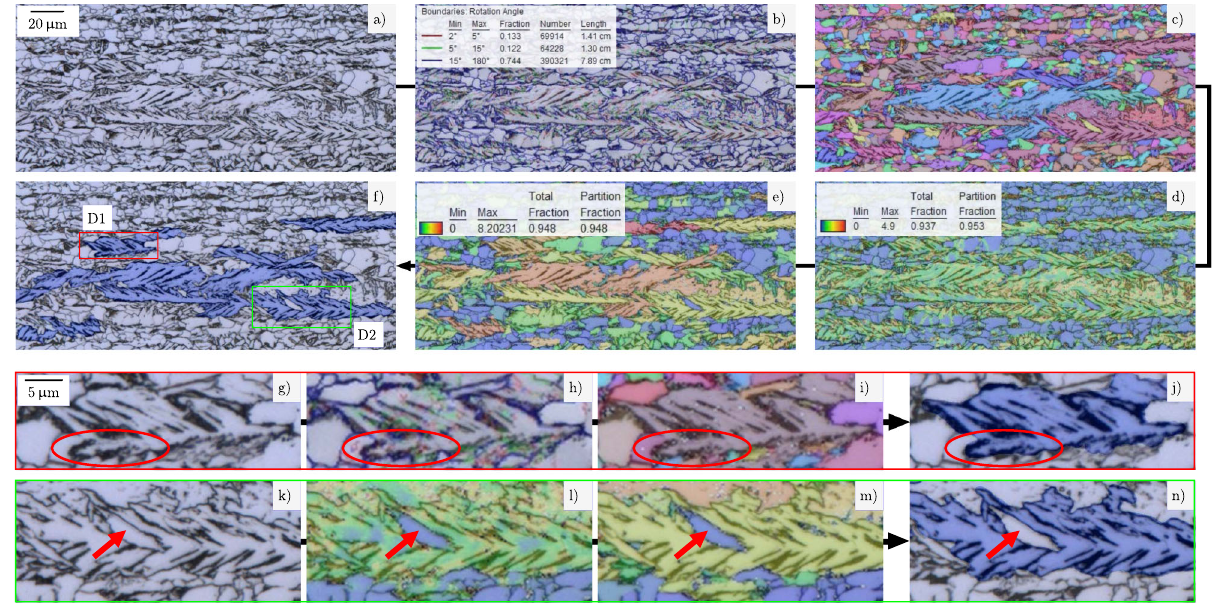
Fig. 1 Illustration of correlative microscopy approach for objectively annotating lath-bainite regions. a Original LOM micrograph. LOM overlayed with b an EBSD-derived grain boundary map, c unique grain color map, d kernel average misorientation (KAM) map, and e grain orientation spread (GOS) map. f LOM with annotated lath-bainite regions based on EBSD information. Detail views D1 (red frame) and D2 (green frame) are highlighted here. D1 in fi gures ( g – j ) displays how h grain boundary and i grain visualizations are used to correctly annotate the exact boundaries of the lath-bainite. In contrast, D2 in fi gures ( k – n ) demonstrates how l KAM and m GOS indicate polygonal ferrite grains in or adjacent to the lath-bainite Table 1 Intersection over Union metrics of U-Net-based networks trained on the light optical microscopy data set for different model initializations and downscaling factors.